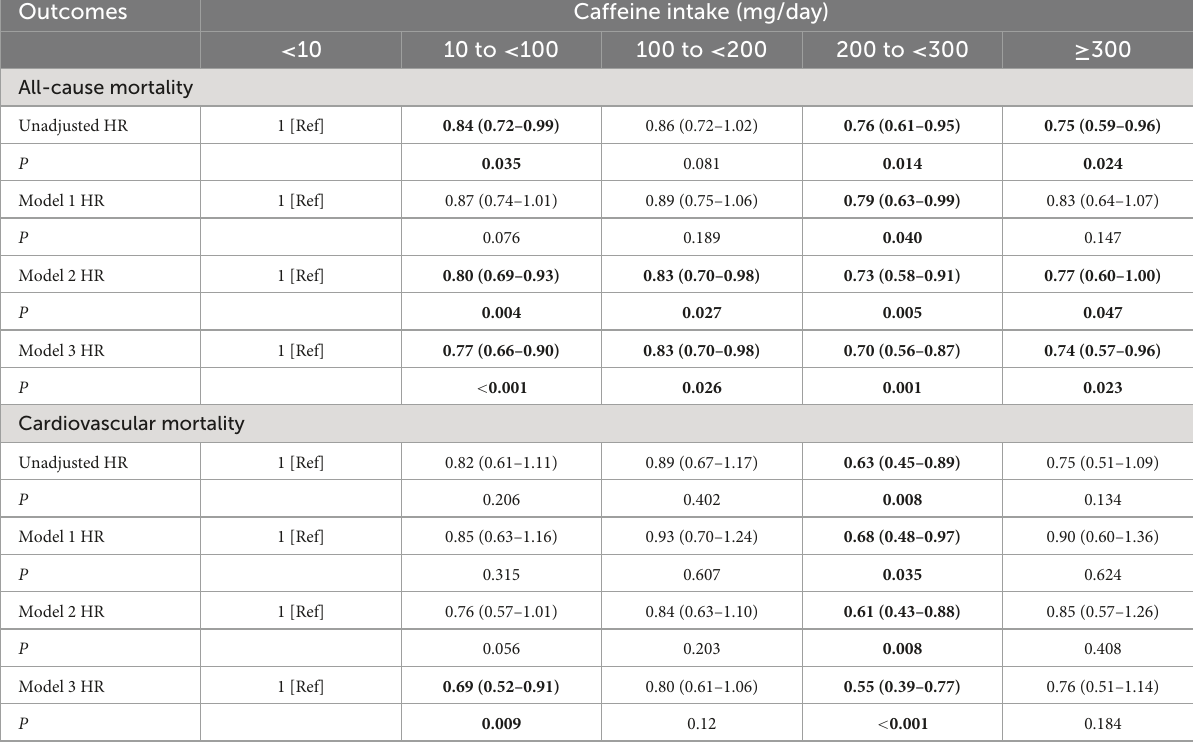
TABLE 2 Hazard ratios for all-cause and cardiovascular mortality of all participants, stratified by caffeine intake.